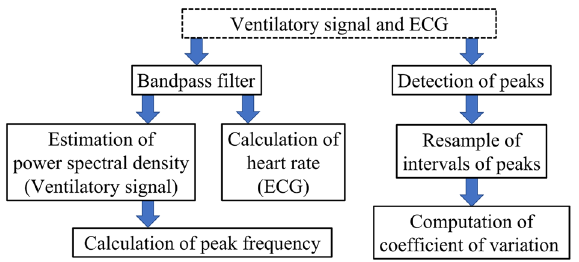
Figure 7. The procedure used to calculate the indices to evaluate ventilation and heart